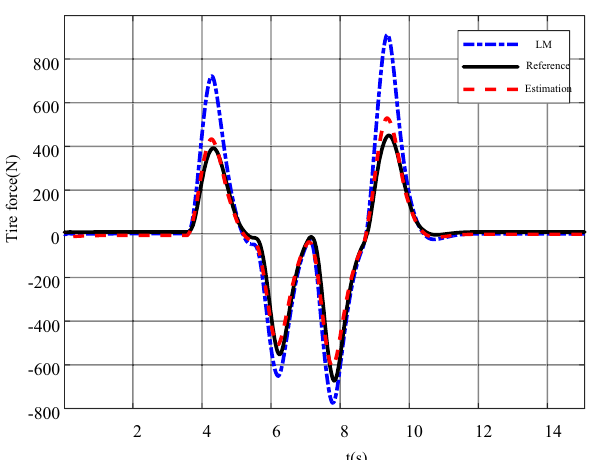
Figure 5 Lateral front left lateral tire force estimation